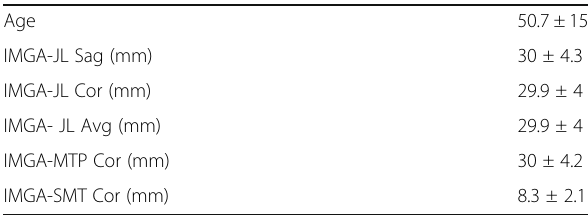
Table 1 Baseline characteristics of patients included in the analysis